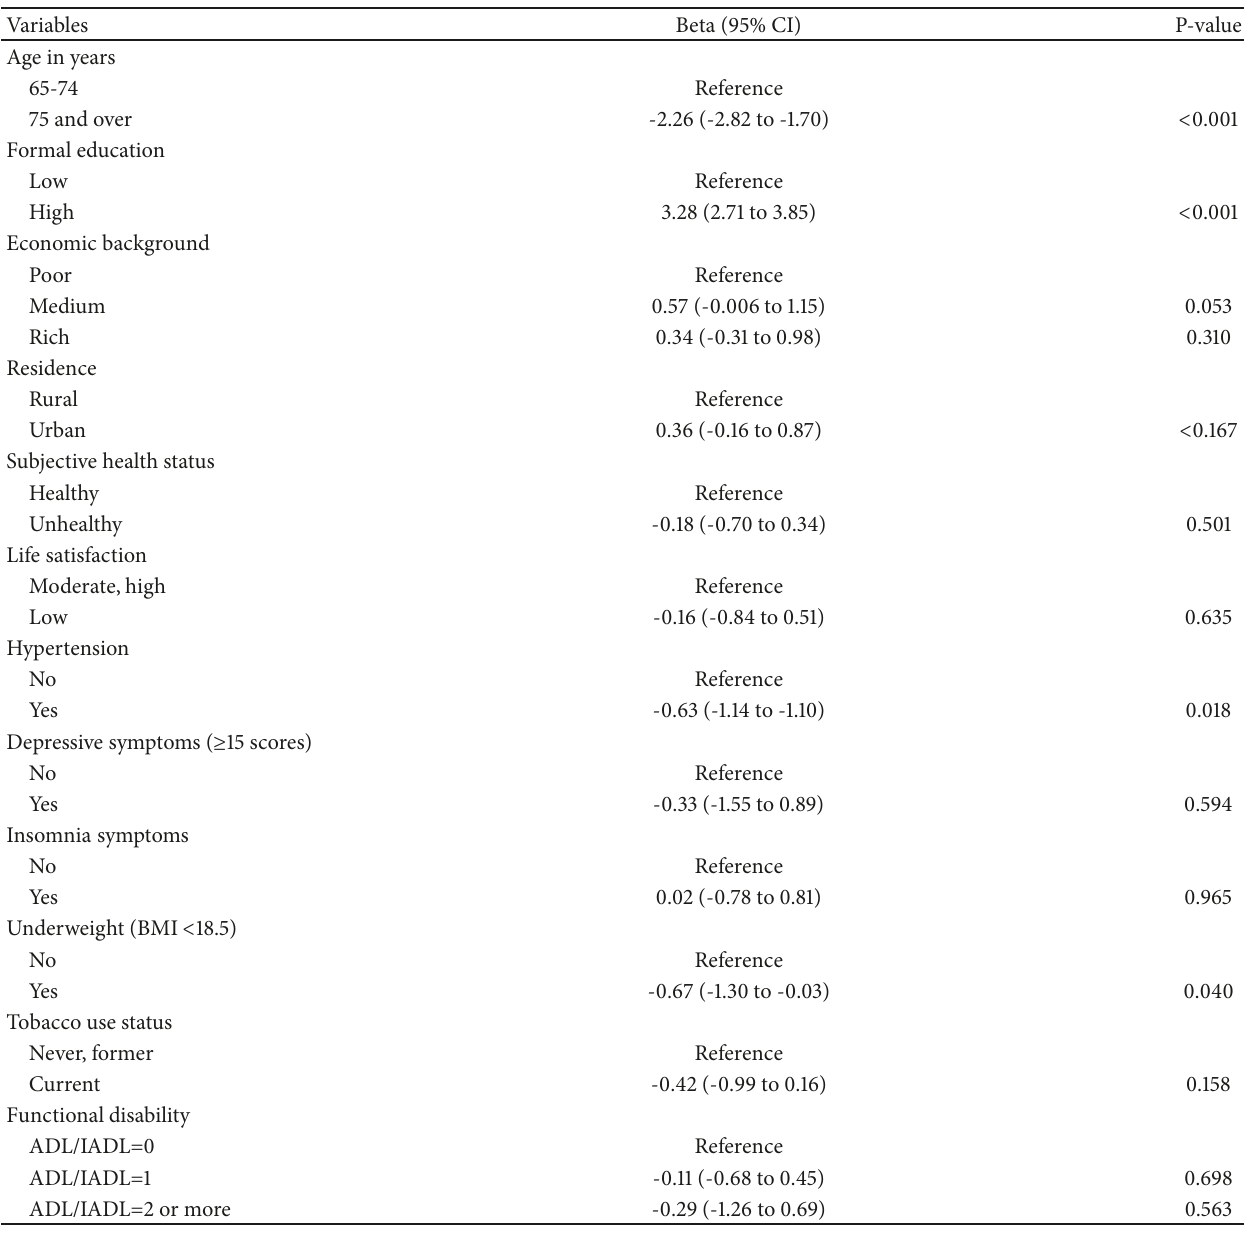
Table 2: Multivariable linear regression analysis of factors in bivariate analysis associated with overall cognitive scores among older adults in